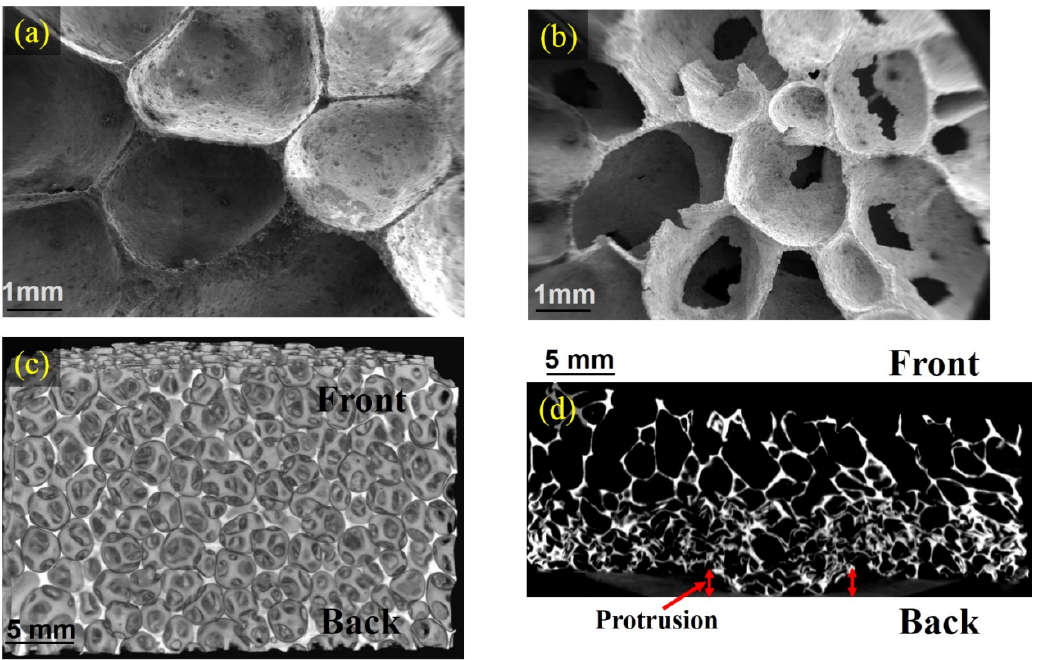
Figure 5. The SEM and 3D CT images of the foam of density 0.31g/cc. ( a ) SEM SE image of the front surface before shock exposure, ( b ) SEM SE image of the front surface after shock exposure, ( c ) 3D CT view before shock exposure, and ( d ) 3D CT view after shock exposure.